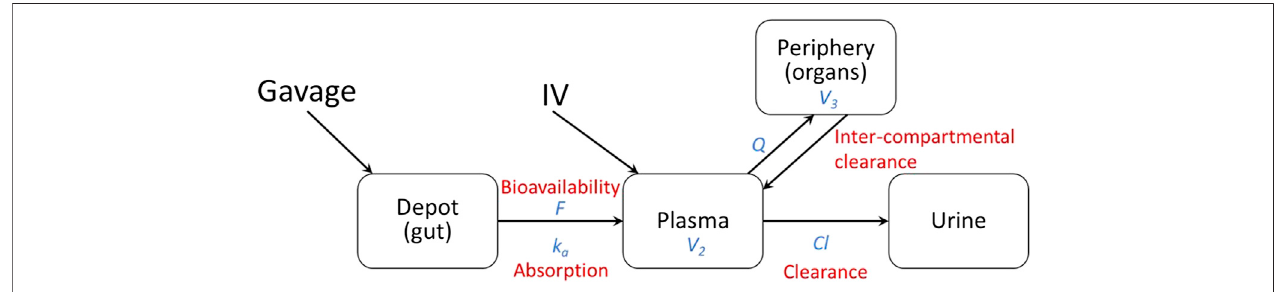
FIGURE 1 | Diagram of two-compartment fi tted